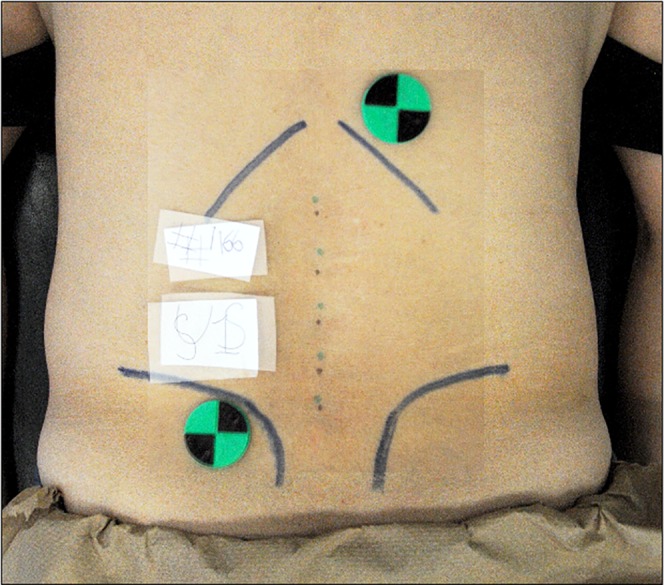
Superimposed images aligned by high contrast black green markers displaying vertebral location markings created by ultrasound operator and Hololens operator.